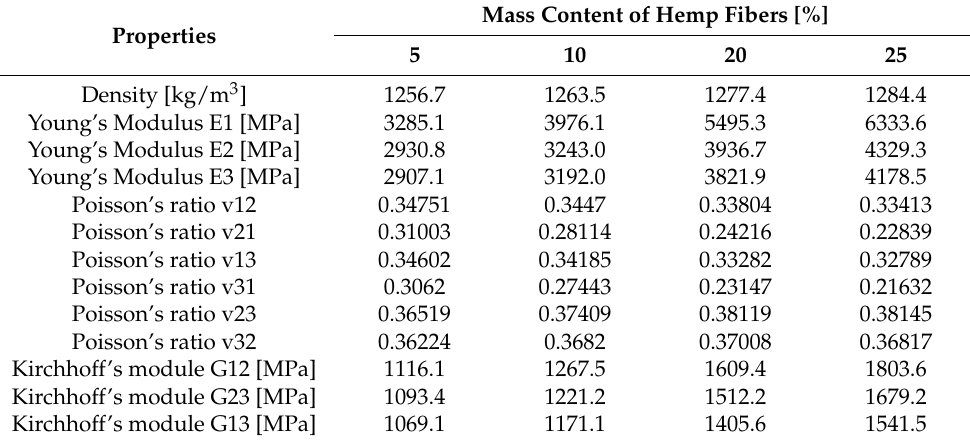
Figure 12. Stress- strain characteristics for various PHBV -hemp fiber biocomposites containing 15% Figure 12. Stress-strain characteristics for various PHBV-hemp fiber biocomposites containing 15% (K15) and 45% (K45) mass filler. (K15) and 45% (K45) mass filler. Table 12. The mechanical properties prediction of the biocomposite PHBV-hemp fiber for the mass share of fibers: 5, 10, 20, and